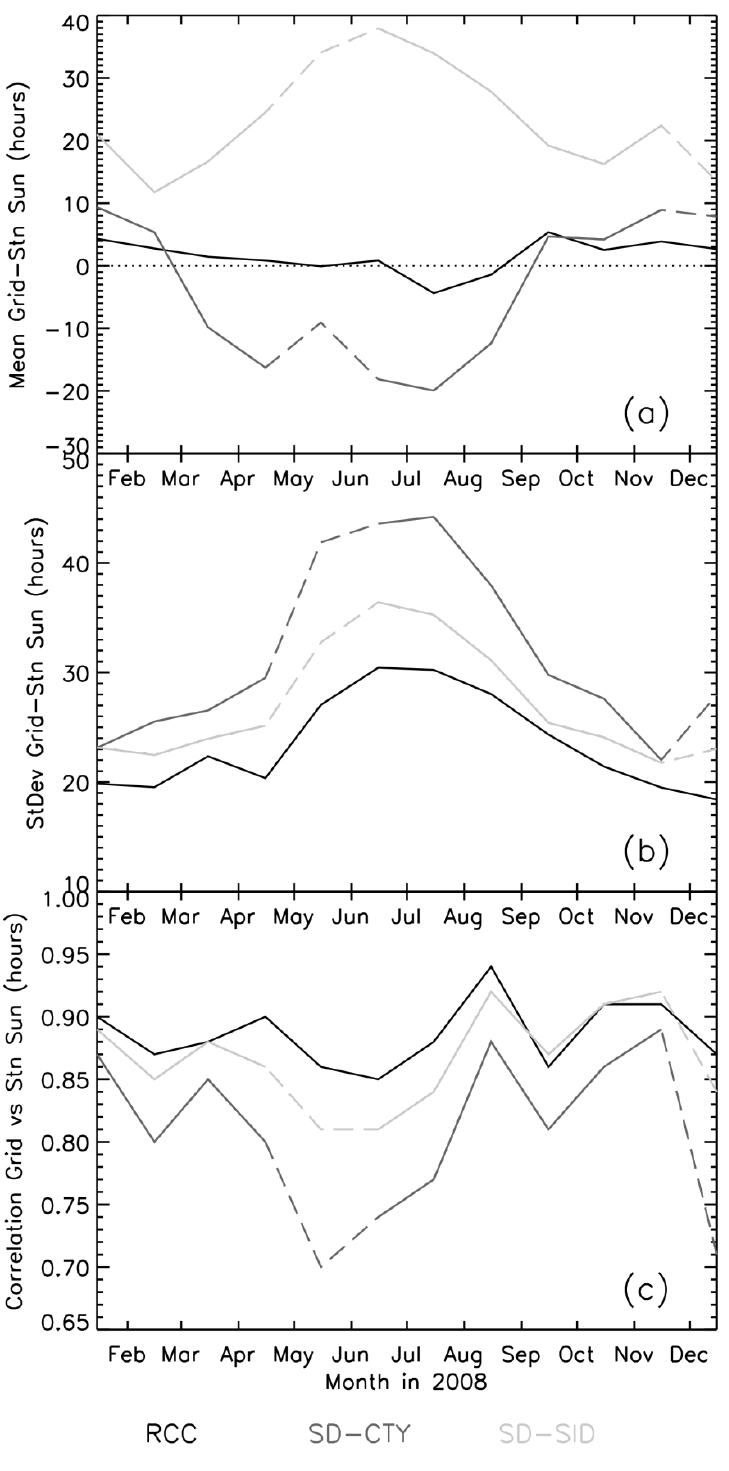
Figure 12. Annual cycles of gridded product minus non-CLIMAT station sunshine duration monthly ( a ) mean differences and ( b ) standard deviation of differences. Panel ( c ) shows the corresponding correlations. Results are shown for SD-RCC (Black), SD-CTY (dark-grey) and SD-SID (light-grey) products. For information, the unofficial monthly totals for May (5 missing days) and December (9 missing days), are dashed in the plot due to missing